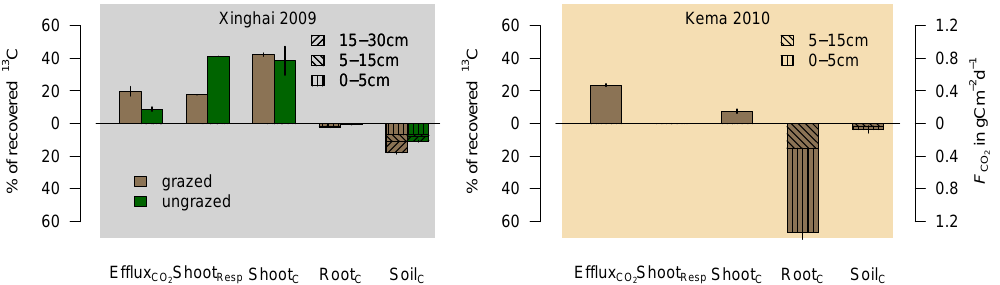
Figure 7. 13 C partitioning and distribution of recently allocated C within the various pools, namely CO 2 efflux, shoot respiration, shoots, roots and soil for Xinghai site (grazed and ungrazed) in 2009 and Kema site (IM) in 2010, determined at the end of a 29 day and 15 day allocation period, respectively. Vertical lines in the bars denote standard errors ( n = 3 for Xinghai 2009 and n = 8 for Kema 2010). Total fluxes of C in gCm − 2 d − 1 to the different C pools at Kema site are based on the combination of eddy-covariance measurements and labelling. Shoot respiration is not measured, but determined as difference between the 13 C recovery at the first sampling and the sampling at the end of the allocation period. First sampling in Xinghai was 1 day after the labelling and in Kema at the labelling day. Figure modified after Hafner et al. (2012) and Ingrisch et al. (2014).